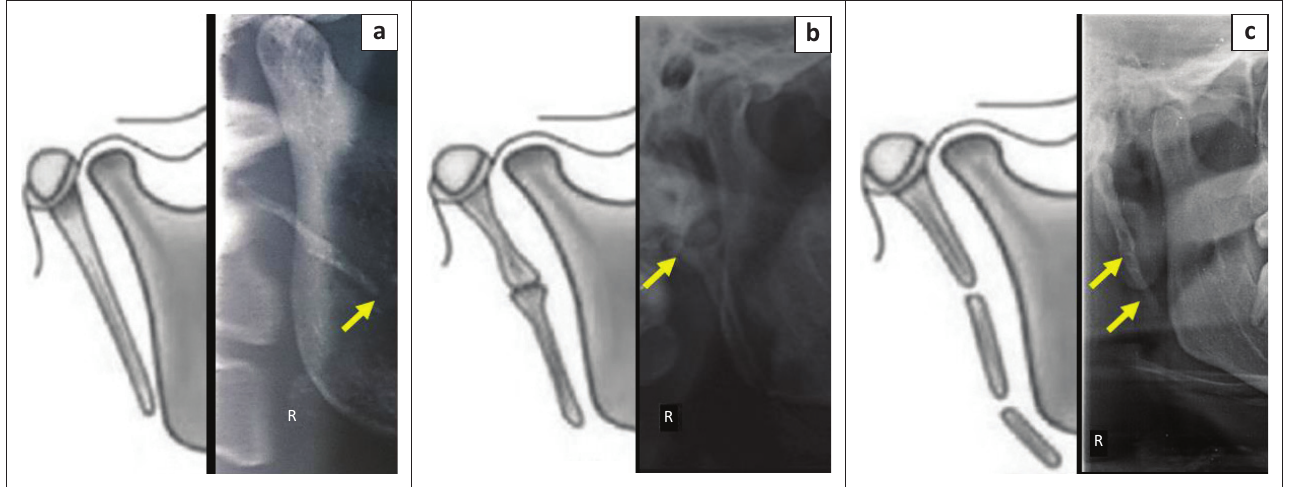
Sources : Adapted from Langlais RP, Miles DA, Van Dis ML. Elongated and mineralized stylohyoid ligament complex: A proposed classification and report of a case of Eagle’s syndrome. Oral Surg Oral Med Oral Pathol. 1986;61:527–532. https://doi.org/10.1016/0030-4220(86)90400-7 FIGURE 2: Radiographic classification system of styloid elongation (a) Type I (b) Type II (c) Type III, according to Langlais et al.